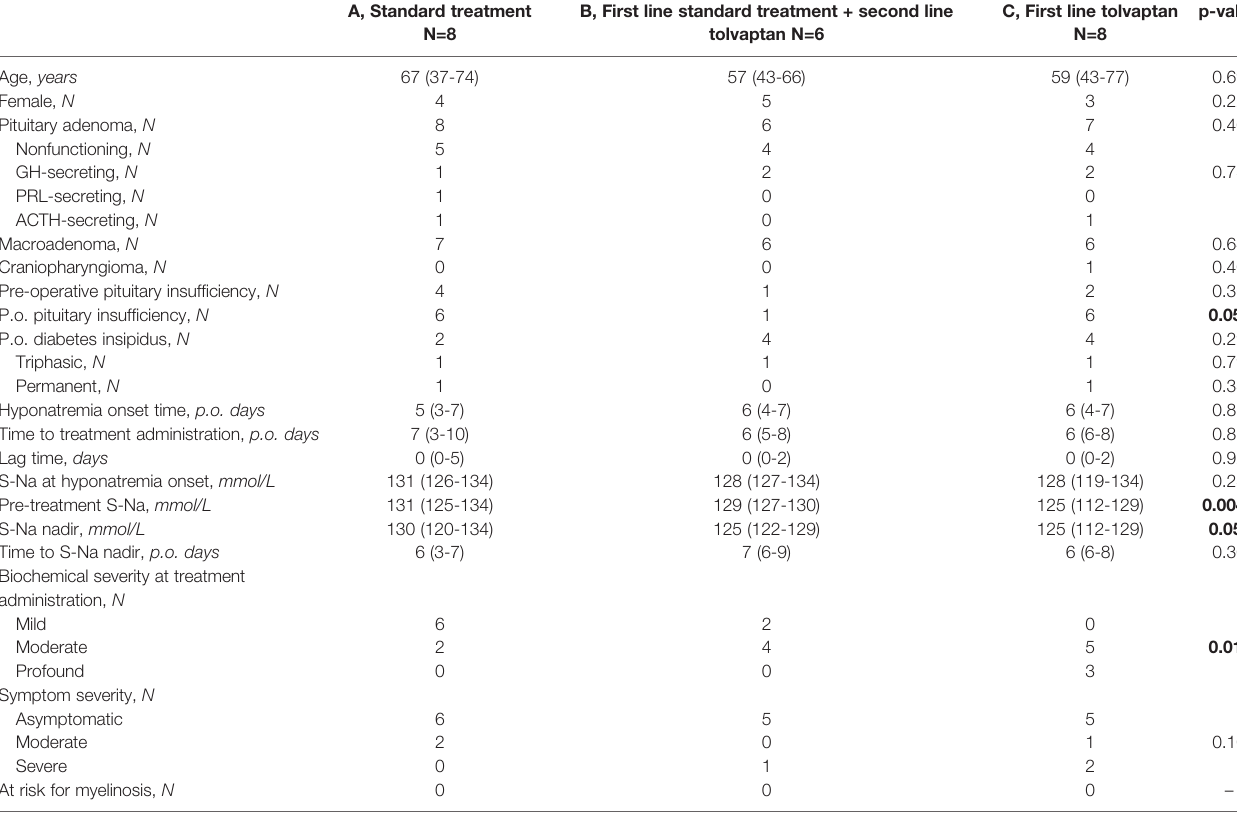
TABLE 1 | Demographics and baseline characteristics of patients treated with standard treatment only (A, N=8), fi rst line standard treatment + second line tolvaptan (B, N=6), and fi rst line tolvaptan (C, N=8).